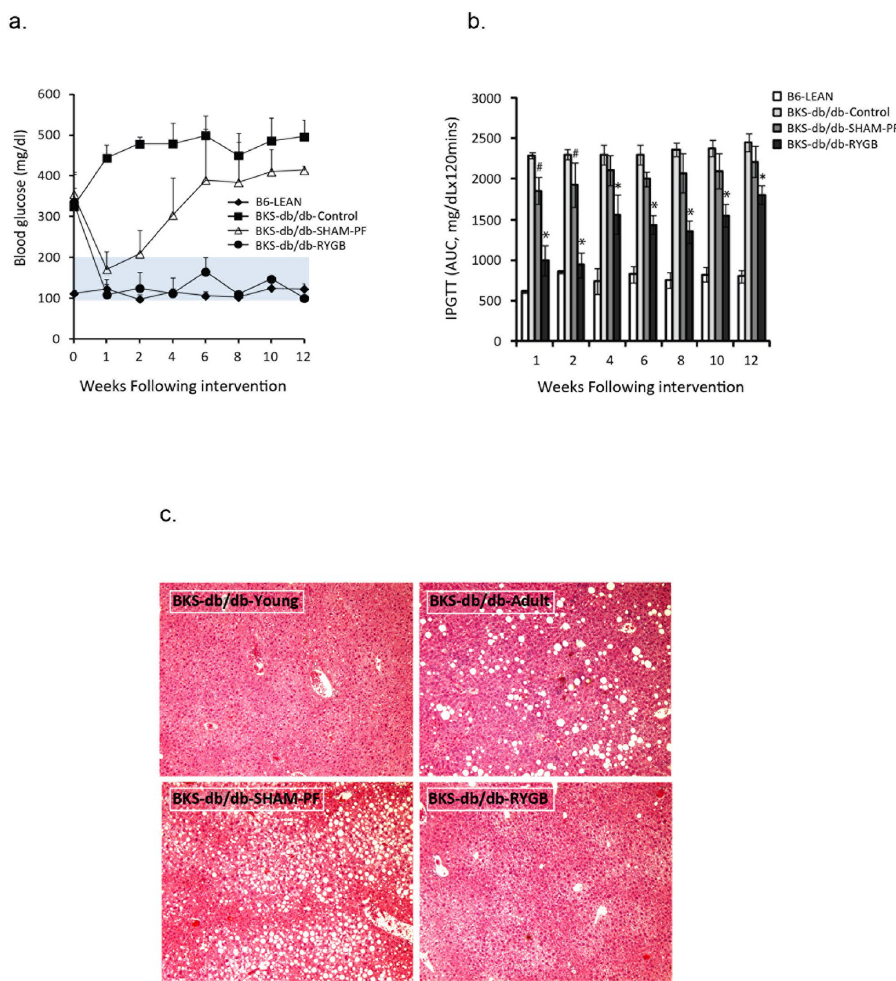
Fig 2. RYGB maintains normoglycemia and improves glucose tolerance and liver steatosis when performed in young prediabetic BKS-db/db mice (6 weeks of age). a. Blood glucose levels. B6-LEAN, Chow-fed WT C57BL/6 (n = 5); BKS-db/db-Control, untreated BKS-db/db mice (n = 5); BKS-db/db-SHAM-PF, BKS-db/db mice with sham surgery and pair-feeding (n = 6), and BKS-db/db-RYGB, BKS-db/db mice with RYGB (n = 8). Mice at 6 weeks of age was defined as 0 week. The shaded area represents a normal range of lean mouse blood glucose levels. BKS-db/db- RYGB vs. BKS-db/db-Control p < 0.001 from the 1 st week to 12 weeks post-surgery. BKS-db/db-SHAM-PF vs. BKS- db/db-Control, p < 0.01 at the first two weeks ( p < 0.05), p > 0.05 from 4 to 10 weeks and p < 0.05 at 12 weeks post- surgery. b. Intraperitoneal glucose tolerance tests (IPGTT). B6-LEAN, C57BL/6 mice (n = 5); BKS-db/db-Control, untreated BKS-db/db mice (n = 5); BKS-db/db-SHAM-PF (n = 5), and BKS-db/db-RYGB (n = 7) mice. � : BKS-db/db- RYGB vs. BKS-db/db-Control and BKS-db/db-SHAM-PF, p < 0.001 and #: BKS-db/db-SHAM-PF vs. BKS-db/db- Control, p < 0.05. c. Liver H&E stanning (x 100). BKS-db/db-Young, young prediabetic BKS-db/db (6 weeks of age); BKS-db/db-Adult, adult diabetic BKS-db/db (12 weeks of age); BKS-db/db-SHAM-PF (12 weeks post-surgery) and BKS-db/db-RYGB (12 weeks post-surgery). The figures represent one of three pathological examinations in each